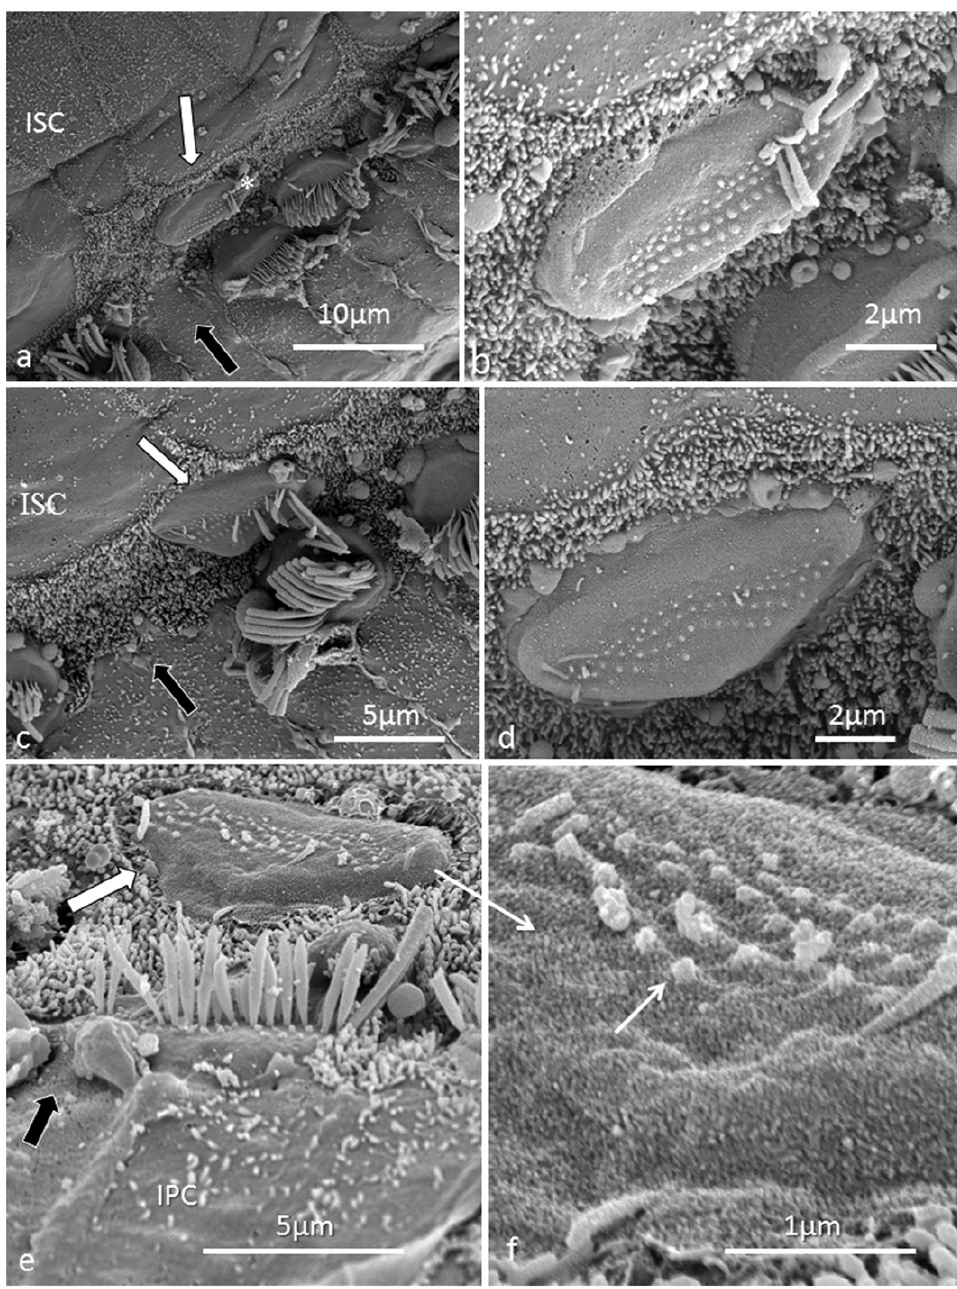
Figure 9. SEM images of sIHCs. Image a: A sIHC is located at the modiolar side of the IHCs near a ‘ gap ’ with a missing IHC. Image b: An image at higher magnifica- tion of the cell shown in Image a. The sIHC stereocilia are rudimentary and stub-like. Image c: A sIHC whose cell surface shows several ciliary stubs and several lon- ger cilia. Image d: Another sIHC near a ‘ gap ’ with a missing IHC. The surface exhibits several stereocilia stubs. Image e: A sIHC (white arrow) is magnified in Image f. A gap with missing IHCs is marked with a dark